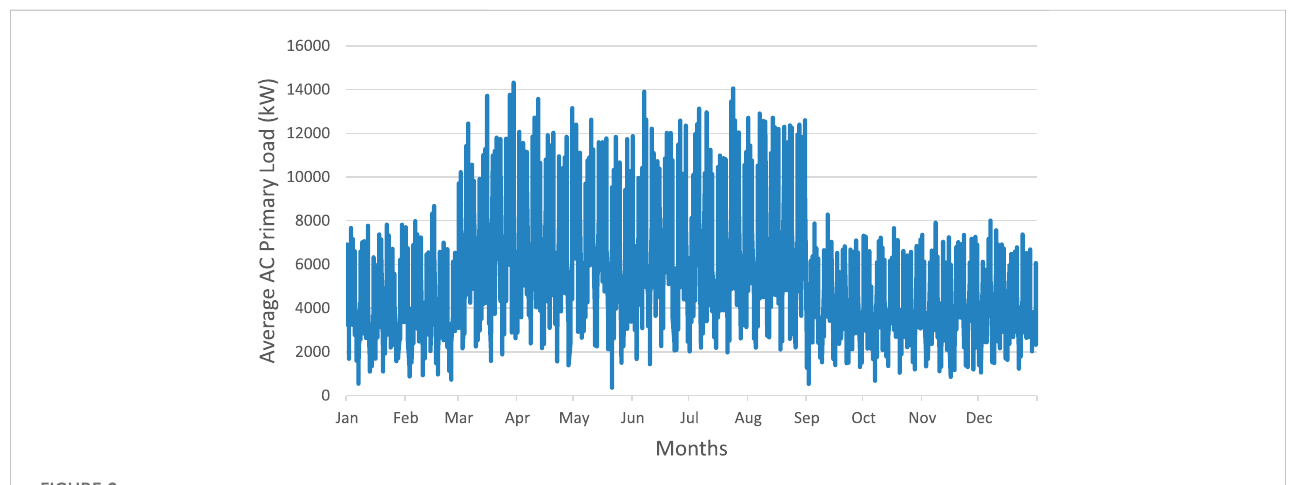
FIGURE 2 Annual average AC primary load (The Ministry of Energy, 2022).